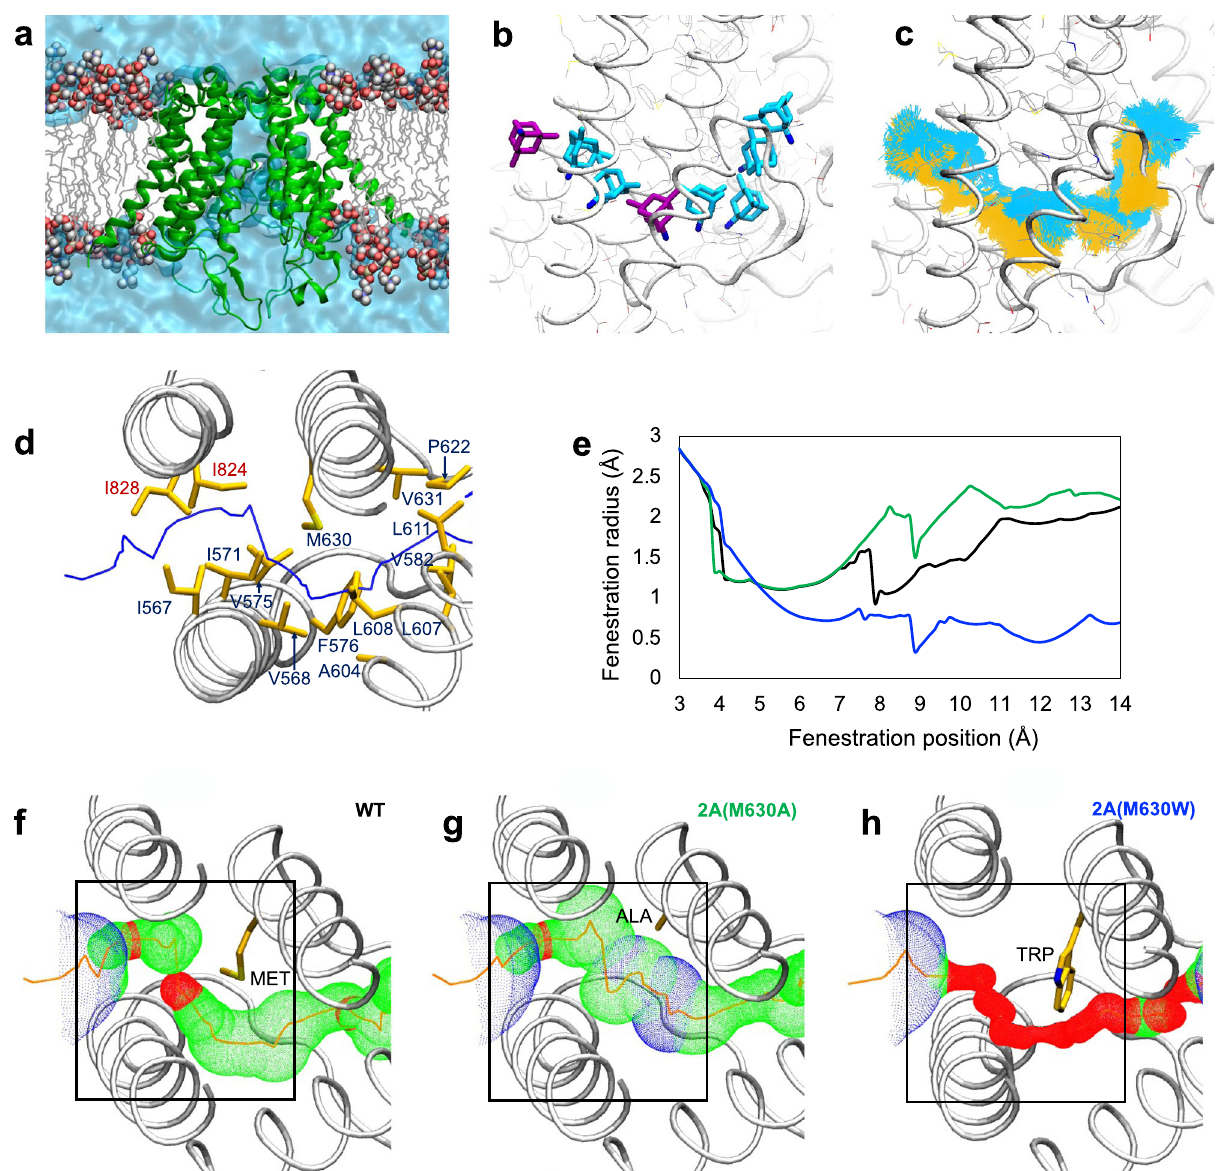
Fig. 5 NMDAR TMD simulations reveal a state-dependent fenestration. a Simulated open NMDAR TMD model (Model 2) in lipid bilayer and water. Protein is shown in green cartoon representation; lipid tails are grey wireframe; lipid head groups are spheres (carbon, grey; oxygen, red; phosphorus, brown; nitrogen, blue); water channel and bulk water are a solid blue surface. b Memantine (in stick representation) shown at multiple locations along the membrane-to-channel path. Snapshots of memantine are shown in the two docked positions (purple) used as starting points for steered MD simulations, and at multiple locations extracted from simulated trajectories (cyan). c Simulated trajectory of memantine from the membrane to the channel obtained using steered MD simulations with the following parameters: (1) k = 10 kcal mol − 1 Å − 2 , t = 60 ns (yellow); and (2) k = 4 kcal mol − 1 Å − 2 , t = 100 ns (cyan), where k = the biasing force constant and t = the total simulation duration. Simulation details are described in Methods. b , c were generated using Model 2. d View of the fenestration from the extracellular solution. The center of the fenestration path is shown as a blue line. Residues lining the channel are shown in yellow stick representation and identi fi ed (GluN1 residues, red labels; GluN2A residues, blue labels). e Fenestration radius along the path shown in d ( “ fenestration position ” ) near position 630 of GluN2A is plotted for WT GluN1/2A (black line), GluN1/2A(M630A) (green line) and GluN1/ 2A(M630W) (blue line) receptors. Position 0 of the fenestration (not shown) corresponds to the outer edge of the NMDAR identi fi ed by HOLE. f – h The portion of the fenestration near position 630 of GluN2A is shown for WT GluN1/2A ( f ), GluN1/2A(M630A) ( g ), and GluN1/2A(M630W) ( h ) receptors. The largest regions of the fenestration identi fi ed using HOLE are shown in blue (radius > 2.30 Å), intermediate regions in green (1.15 Å < radius < 2.30 Å), and most constricted regions in red (radius < 1.15 Å). The residue at position 630 is identi fi ed and shown in stick representation. Black boxes show the portion of the fenestration plotted in e . d – h were generated using Model We identi fi ed multiple continuous paths from lipid to the ion channel, and we observed diffusion of K + through the external channel in both closed and open NMDAR TMD structures using gate of Model 2 (Supplementary Movie 1). However, it is the pore predicting program HOLE 56 . We found a single lipid to important to acknowledge that these models may not represent fully open NMDAR states. channel path (fenestration) unique to the open structure. The